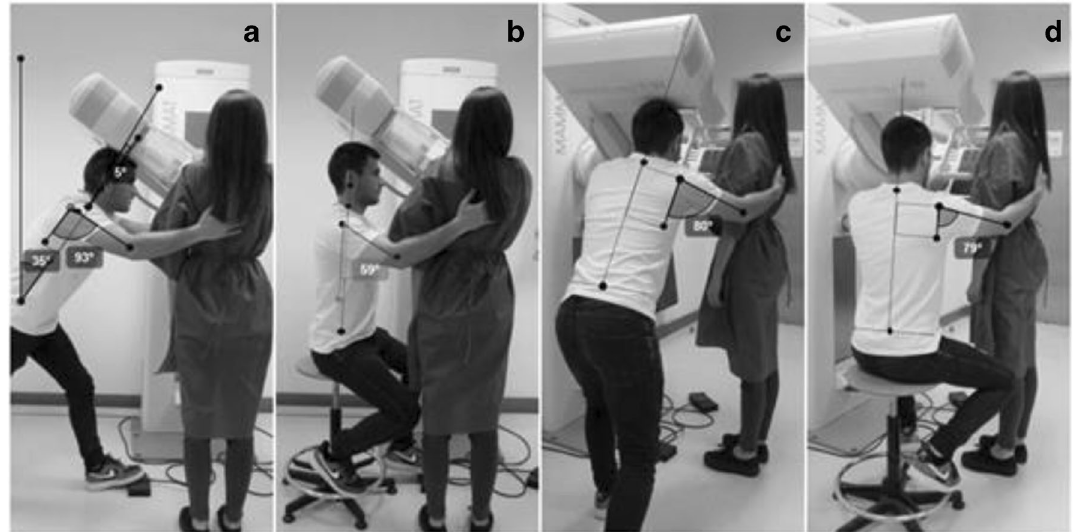
Fig. 2 MLO breast positioning: a and c radiographer postures without intervention; b and d alternative postures when the radiographer and patient have identical statures